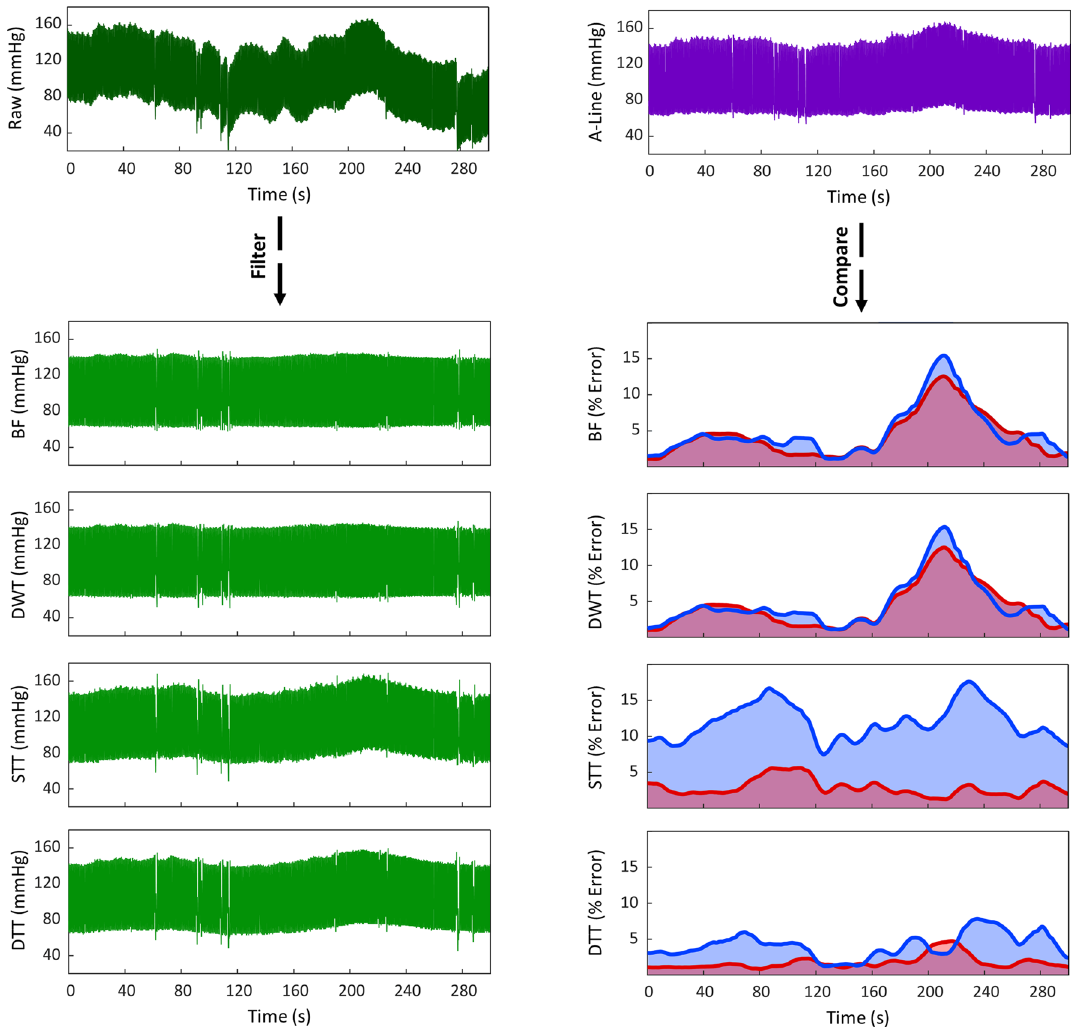
Figure 2. Evaluating algorithm accuracy and BP tracking ability. (left) A 300-s BP recording from the CAP sensor was processed using four different methods: bandpass filter (BF), discrete wavelet transformation (DWT), slope transit time (STT), and diastolic transit time (DTT). (right) BP estimates from the processed signals were compared to A-line measurements to assess errors in SBP (red line) and DBP (blue